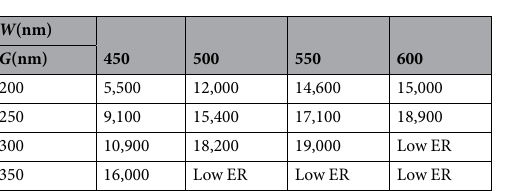
Table 1. Quality factor for ring resonators using the quasi – TE mode with different W and G at 1550